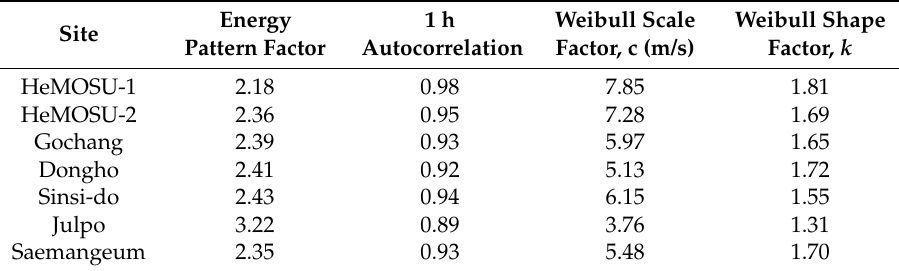
Table 8. Comparison of wind statistics of the meteorological tower measurements.